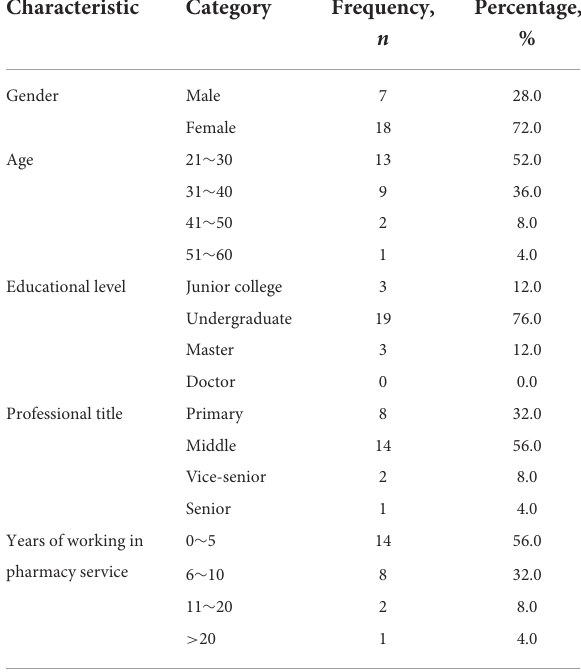
TABLE 3 Social-demographic profile of all twenty-five